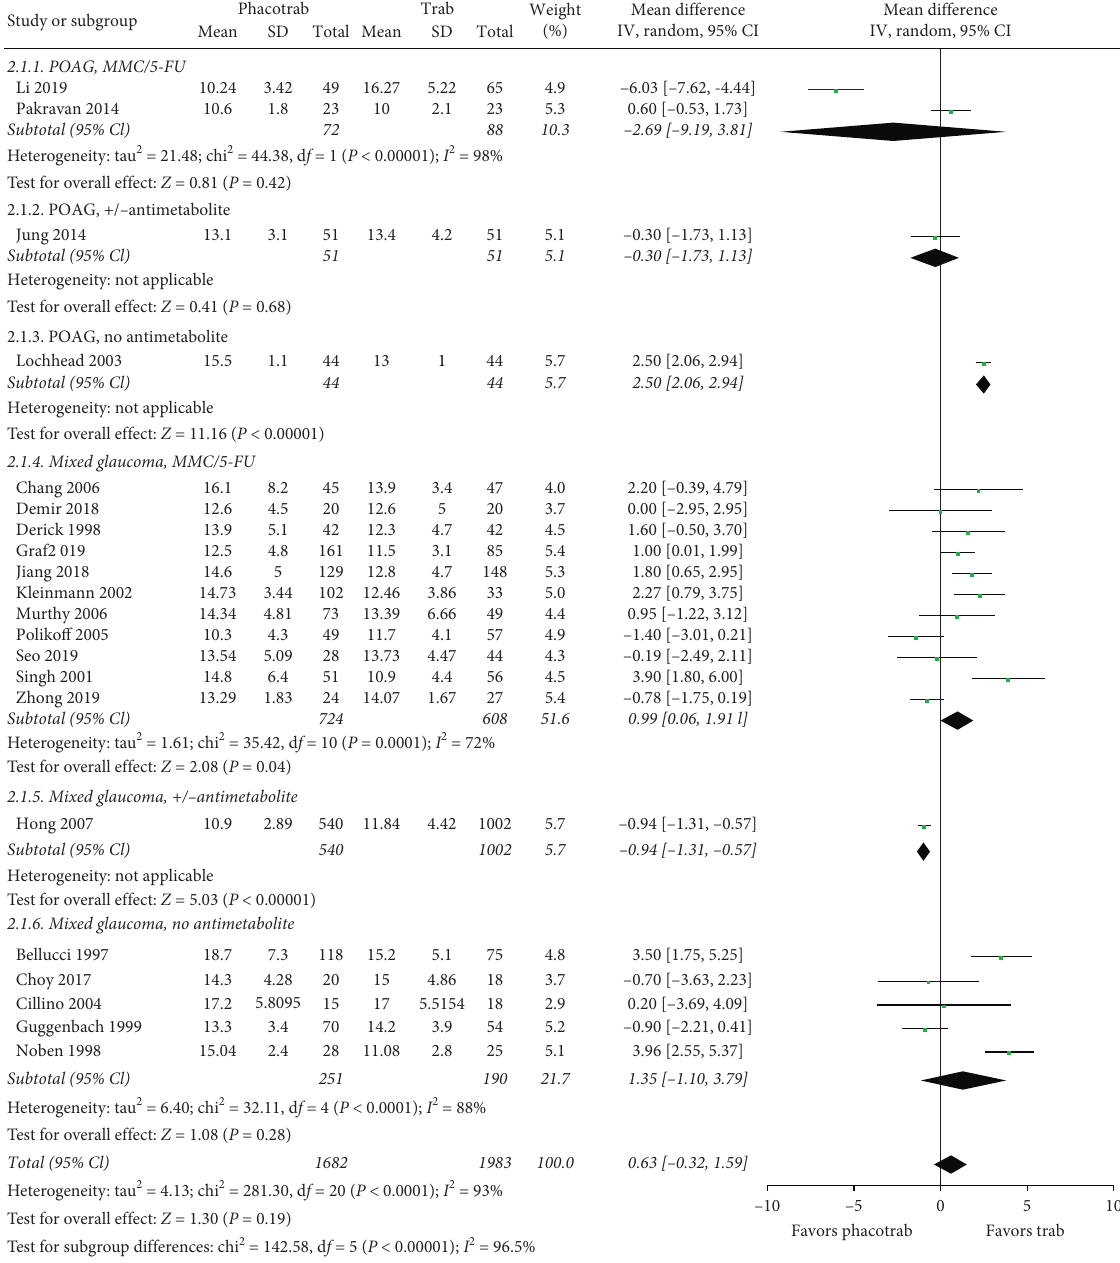
Figure 2: Forest plot of the IOP control at latest follow-up in eyes undergoing phacotrabeculectomy or trabeculectomy only. CI � confidence interval; d f � degrees of freedom; IV � inverse variance; SD � standard deviation. MMC � mitomycin c; 5-FU � 5-fluoro- uracil; +/ − antimetabolite � not all eyes received antimetabolite during the